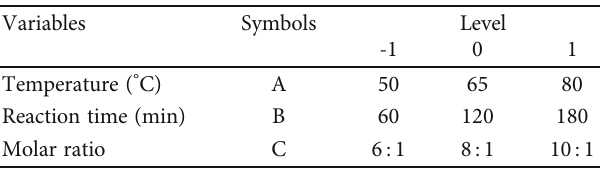
Table 3: Parameter of independent variables used by the BB plan for the optimization of oil transesteri fi cation of the oil Podocarpus